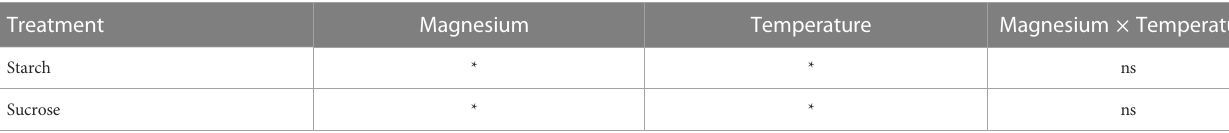
TABLE 5 Results of Two-way ANOVAs on tobacco carbohydrate parameters. Treatment